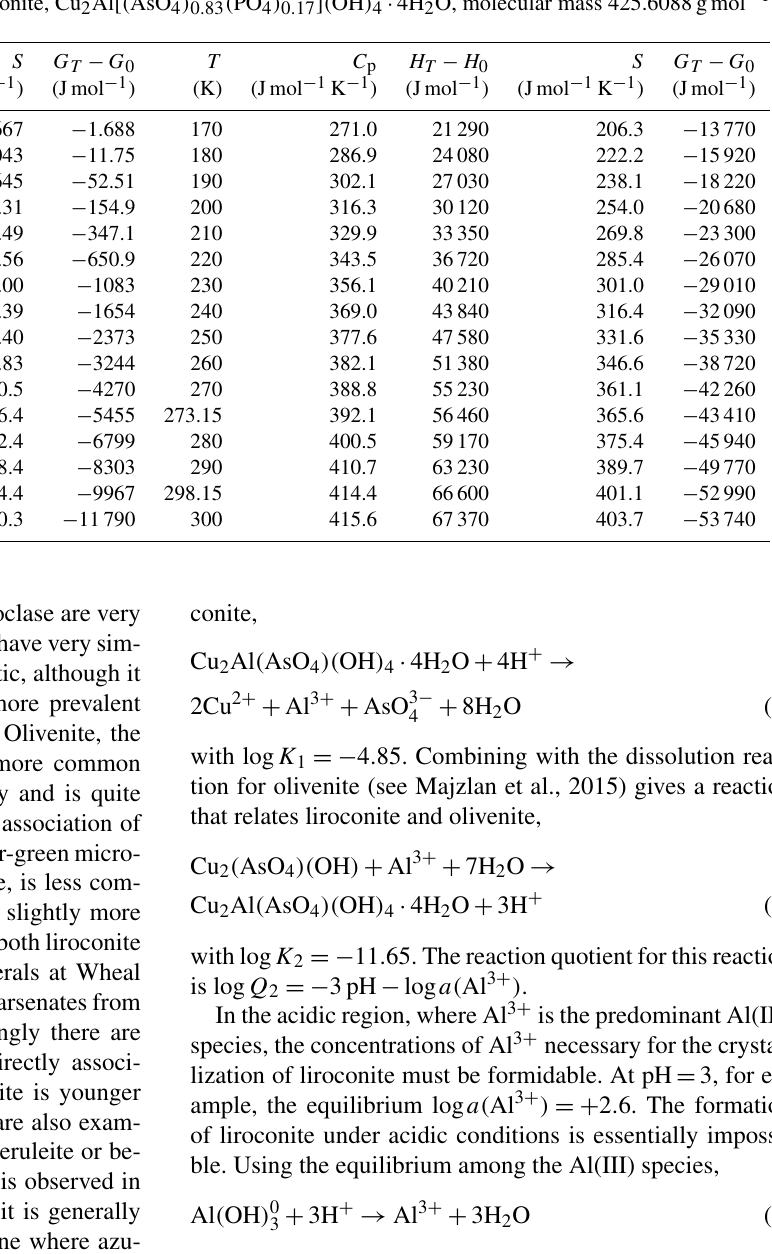
Table 11. Molar thermodynamic functions for liroconite, Cu 2 Al [ ( AsO 4 ) 0 . 83 ( PO 4 ) 0 . 17 ] ( OH ) 4 · 4H 2 O, molecular mass 425.6088gmol − 1